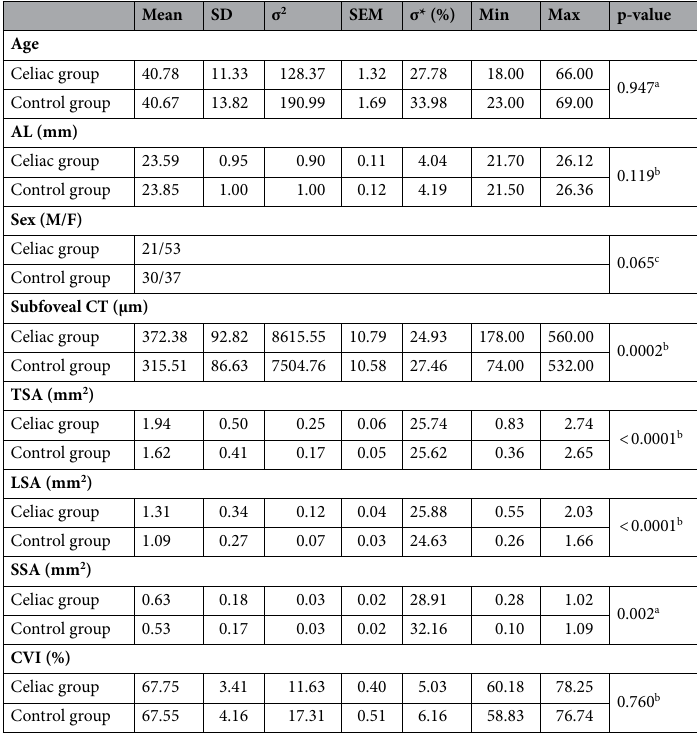
Table 1. Clinical and Choroidal Characteristics of the two study groups. SD standard deviation, σ 2 variance, SEM standard error of the mean, σ* variation coefficient, AL axial length, CT choroidal thickness, TSA total subfoveal area, LSA luminal subfoveal area, SSA stromal subfoveal area, CVI choroidal vascularity index.